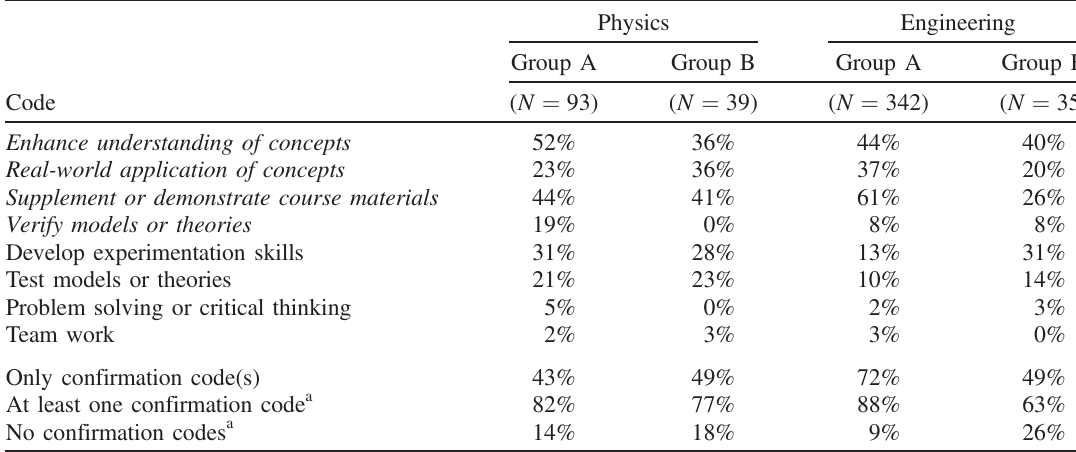
TABLE II. Codes applied to students ’ responses to “ What do you believe is the purpose of a physics lab? ” Italics indicate confirmation codes. Both introductory sequences include students who intend to pursue physics, engineering, and other majors; the labels indicate the most common major in the sequence. Students in group A answered the question prior to receiving instruction on the learning goals of the lab. Students in group B answered the question during or after receiving instruction on the learning goals of the lab. All students provided responses during the first lab session and prior to the lab activity described in this